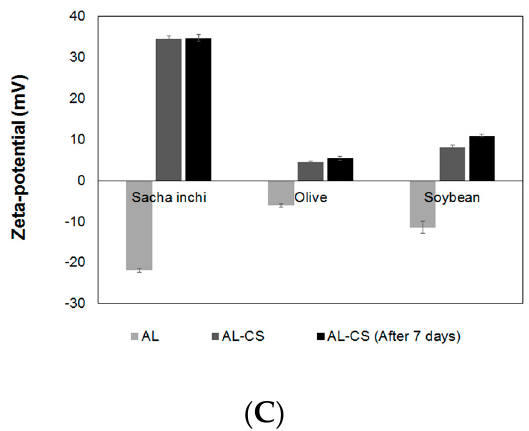
Figure 3. Effect of the type of oil on the properties of AL nanoemulsion (AL) and CS coated AL particles (AL-CS) on the particle size ( A ), size polydispersity ( B ), and zeta-potential ( C ), when prepared and after seven days. PDI, polydispersity index.